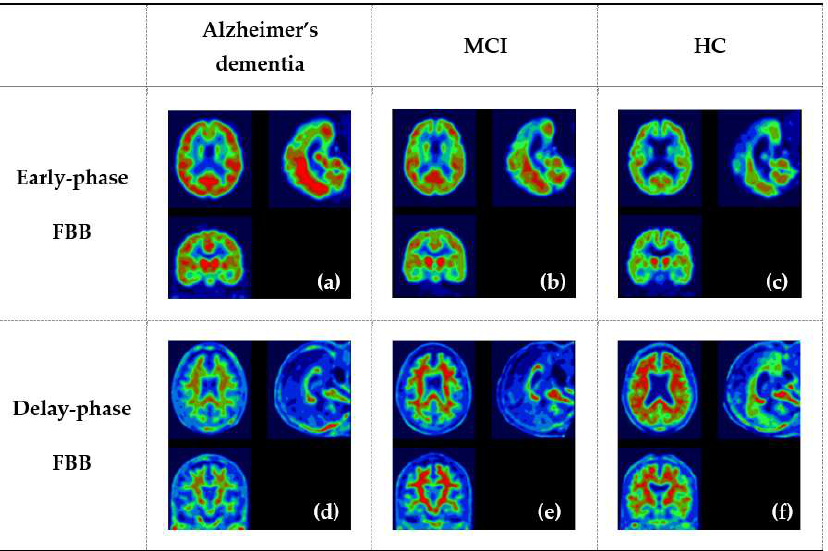
Figure 2. Dual-phase FBB images of subjects. The time range for dFBB is 90–110 min, and the time